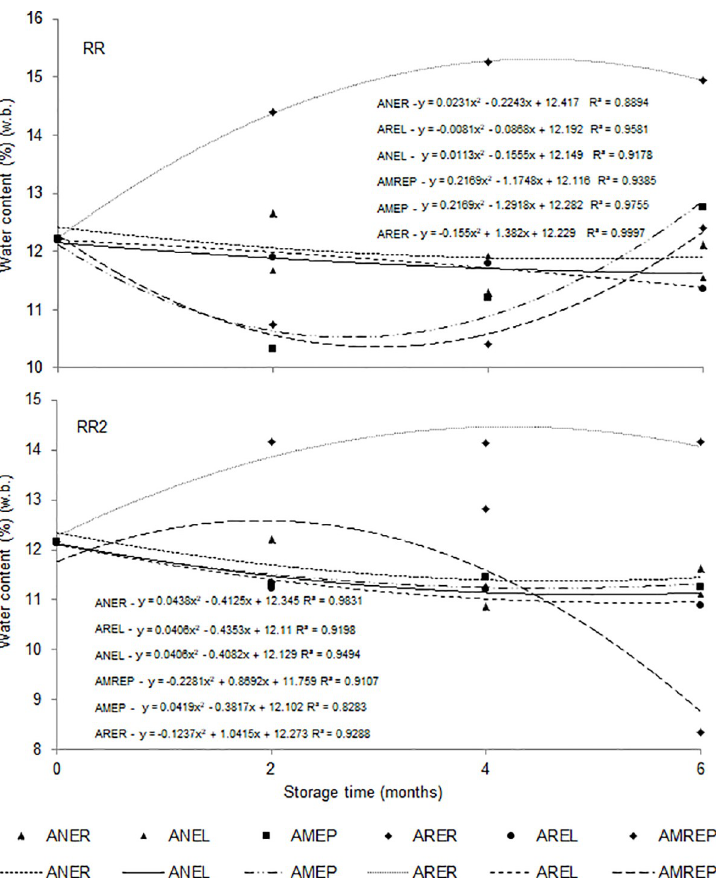
Fig 3. Water content (% w.b.) in soybean seeds of cultivar RR and RR2 as a function of different conditions and storage time. Ambient air + raffia packaging—ANER, ambient air + packaging laminate packaging—ANEL, modified atmosphere (-14 PSI) + polyethylene packaging—AMEP, refrigerated atmosphere (1 to 3˚C) + raffia packaging— ARER, refrigerated atmosphere (1 to 3˚C) + laminate packaging—AREL, modified atmosphere (-14 PSI) + polyethylene packaging + refrigerated (1 to